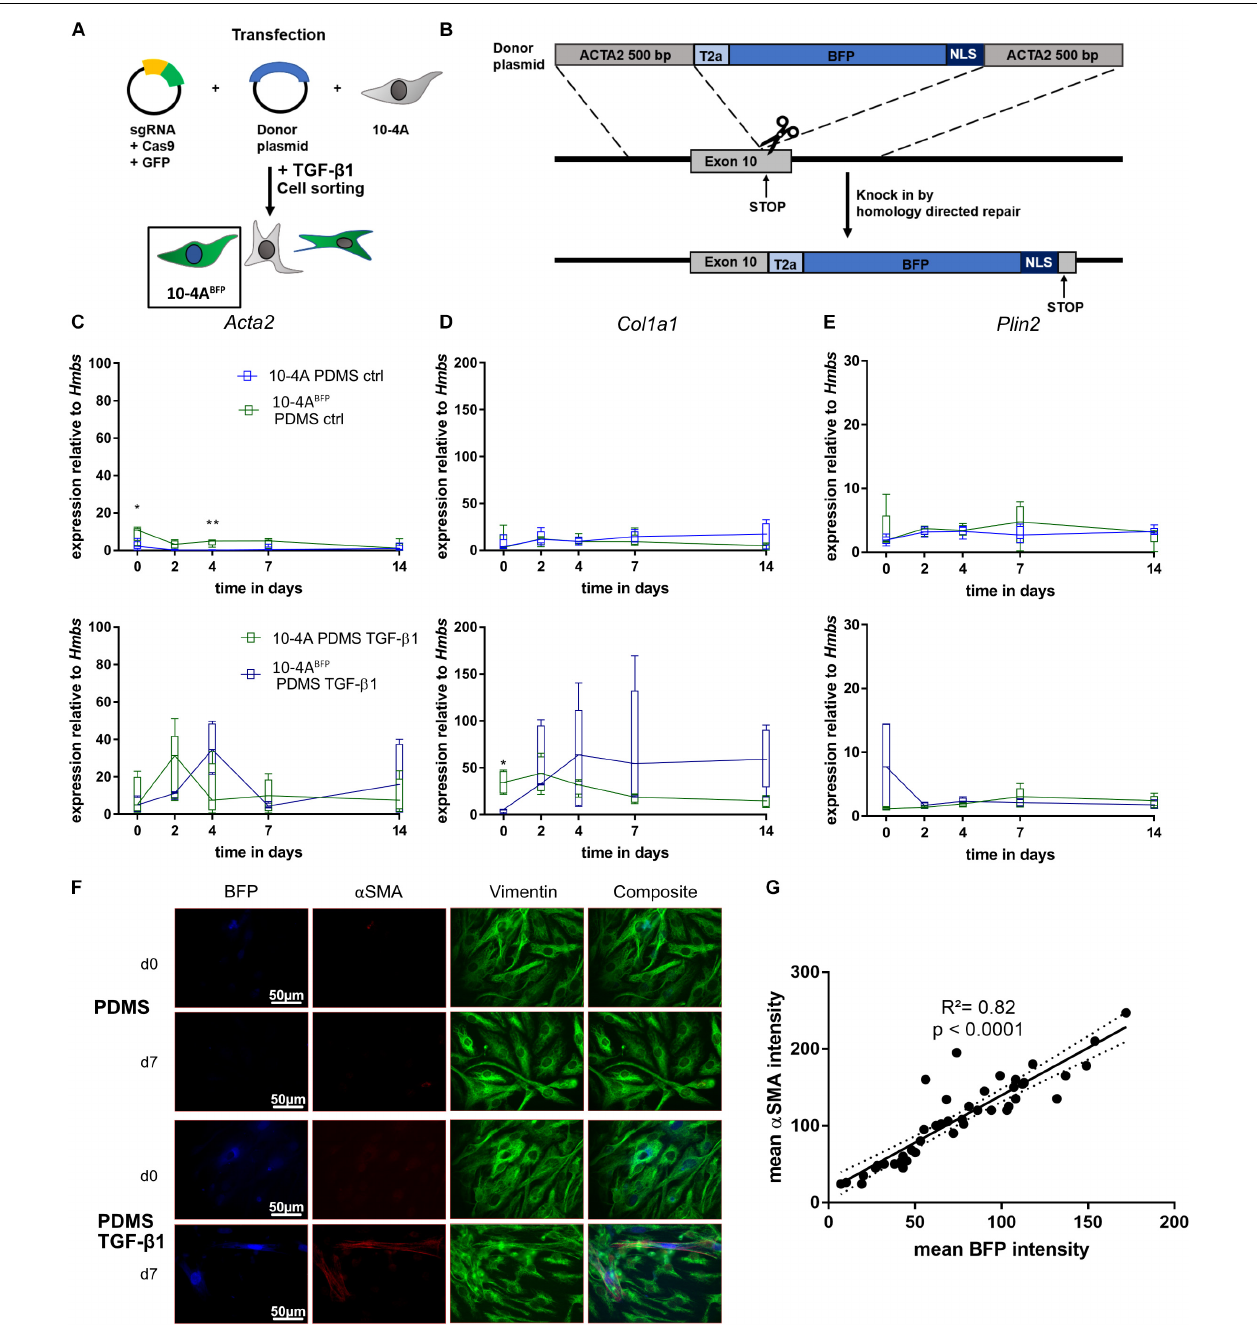
FIGURE 6 | Generation and verification of an Acta2 coupled BFP reporter cell line. (A,B) Schematic representation of 10-4A cell transfection. Cells were transfected with a plasmid containing Cas9 and the sgRNA binding at the desired gene (exon 10) and a donor plasmid. The donor plasmid contained a BFP flanked by a self-cleaving T2A cassette, a nuclear localization sequence and two 500 bp homologous arms of the sgRNA cutting site. After cell transfection, Acta2 gene expression was induced by addition of 5 ng/ml TGF- β 1 and cells were FACS sorted for BFP. Semi-quantitative RT-PCR analysis of Acta2 (C) , Col1a1 (D) , and Plin2 (E) expression in 10-4A and 10-4A BFP cells with and without administration of 5 ng/ml TGF- β 1 on a soft PDMS substrate, respectively. Values are means from five individual culture experiments. The respective time points were tested with the non-parametric Mann–Whitney- U -Test. Statistical significance is indicated as follows: p -values < 0.05: *, p -values < 0.01: **. Box plots show data as median values, the boxes represent percentiles, the whiskers indicate the minimum/maximum. (F) Immunofluorescence staining of 10-4A BFP cells seeded on PDMS with and without administration of 5 ng/ml TGF- β 1 directly after adherence (d0) or 7 days post-seeding. Cells were monitored for BFP and stained for the mesenchymal marker vimentin (green) and the pro-fibrotic protein α SMA (red). Scale bar = 50 µ m. (G) Correlation of the BFP and α SMA signal intensity within individual cells 7 days post seeding. N = 48 cells. A linear regression line and the corresponding indicator R and p -value show the linear dependency of BFP and α SMA